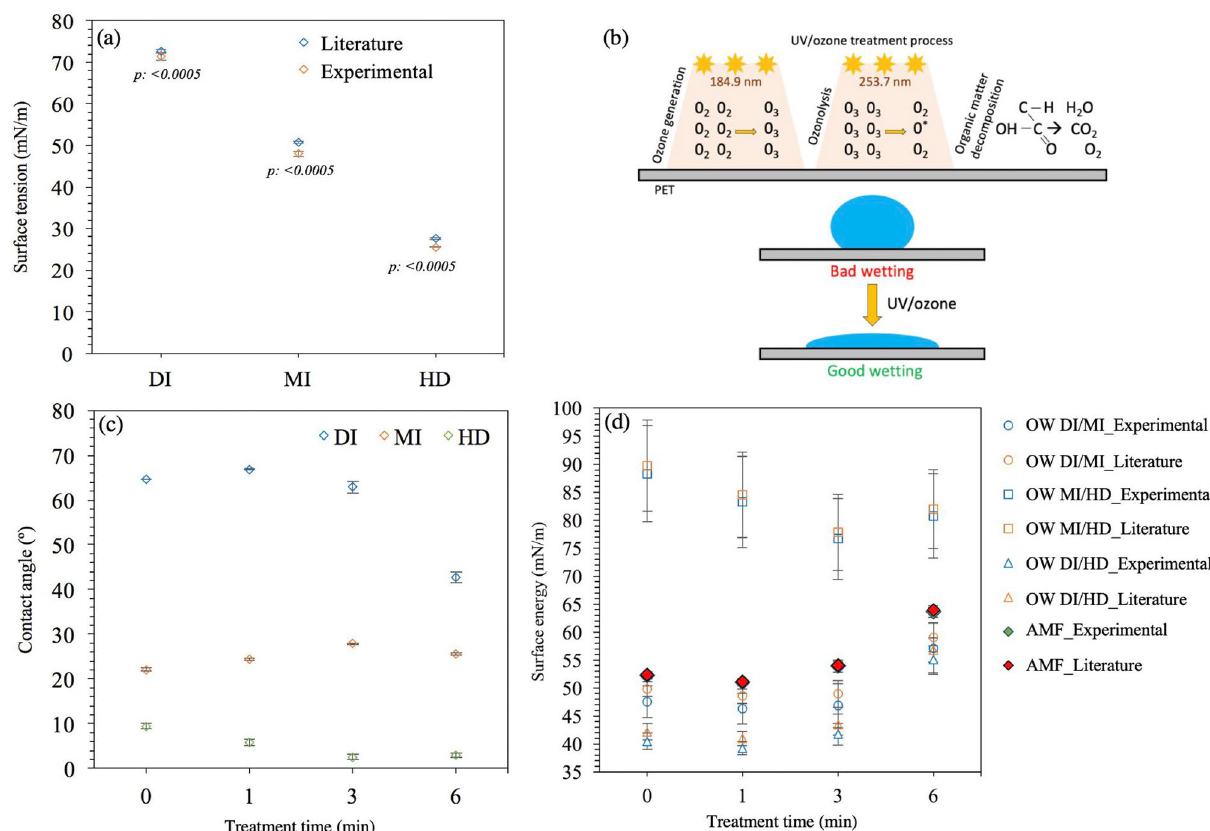
Figure 1. ( a ) Comparison of surface tension values found in the literature and experimented in the lab, ( b ) UV/ozone treatment process, ( c ) contact angles of test liquids on PET as a function of treatment time, ( d ) comparison of PET surface energy based on the OW and